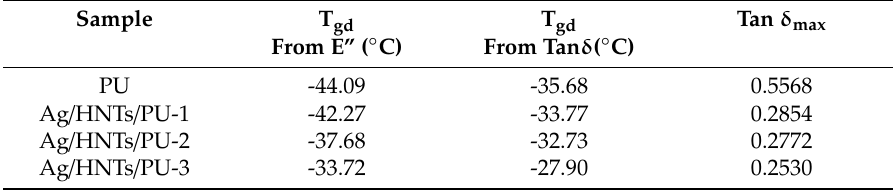
Figure 8. Dynamic mechanical analysis of the Ag / HNTs / PU, ( a ) Tan δ , ( b ) loss modulus (E”), ( c ) storage modulus. Table 4. Dynamic mechanical analysis (DMA) results of the Ag / HNTs /